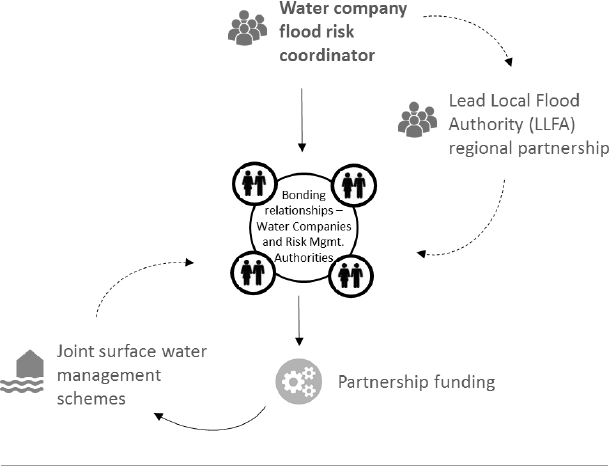
Fig. 4 . Demonstration of the interplay between mechanisms and